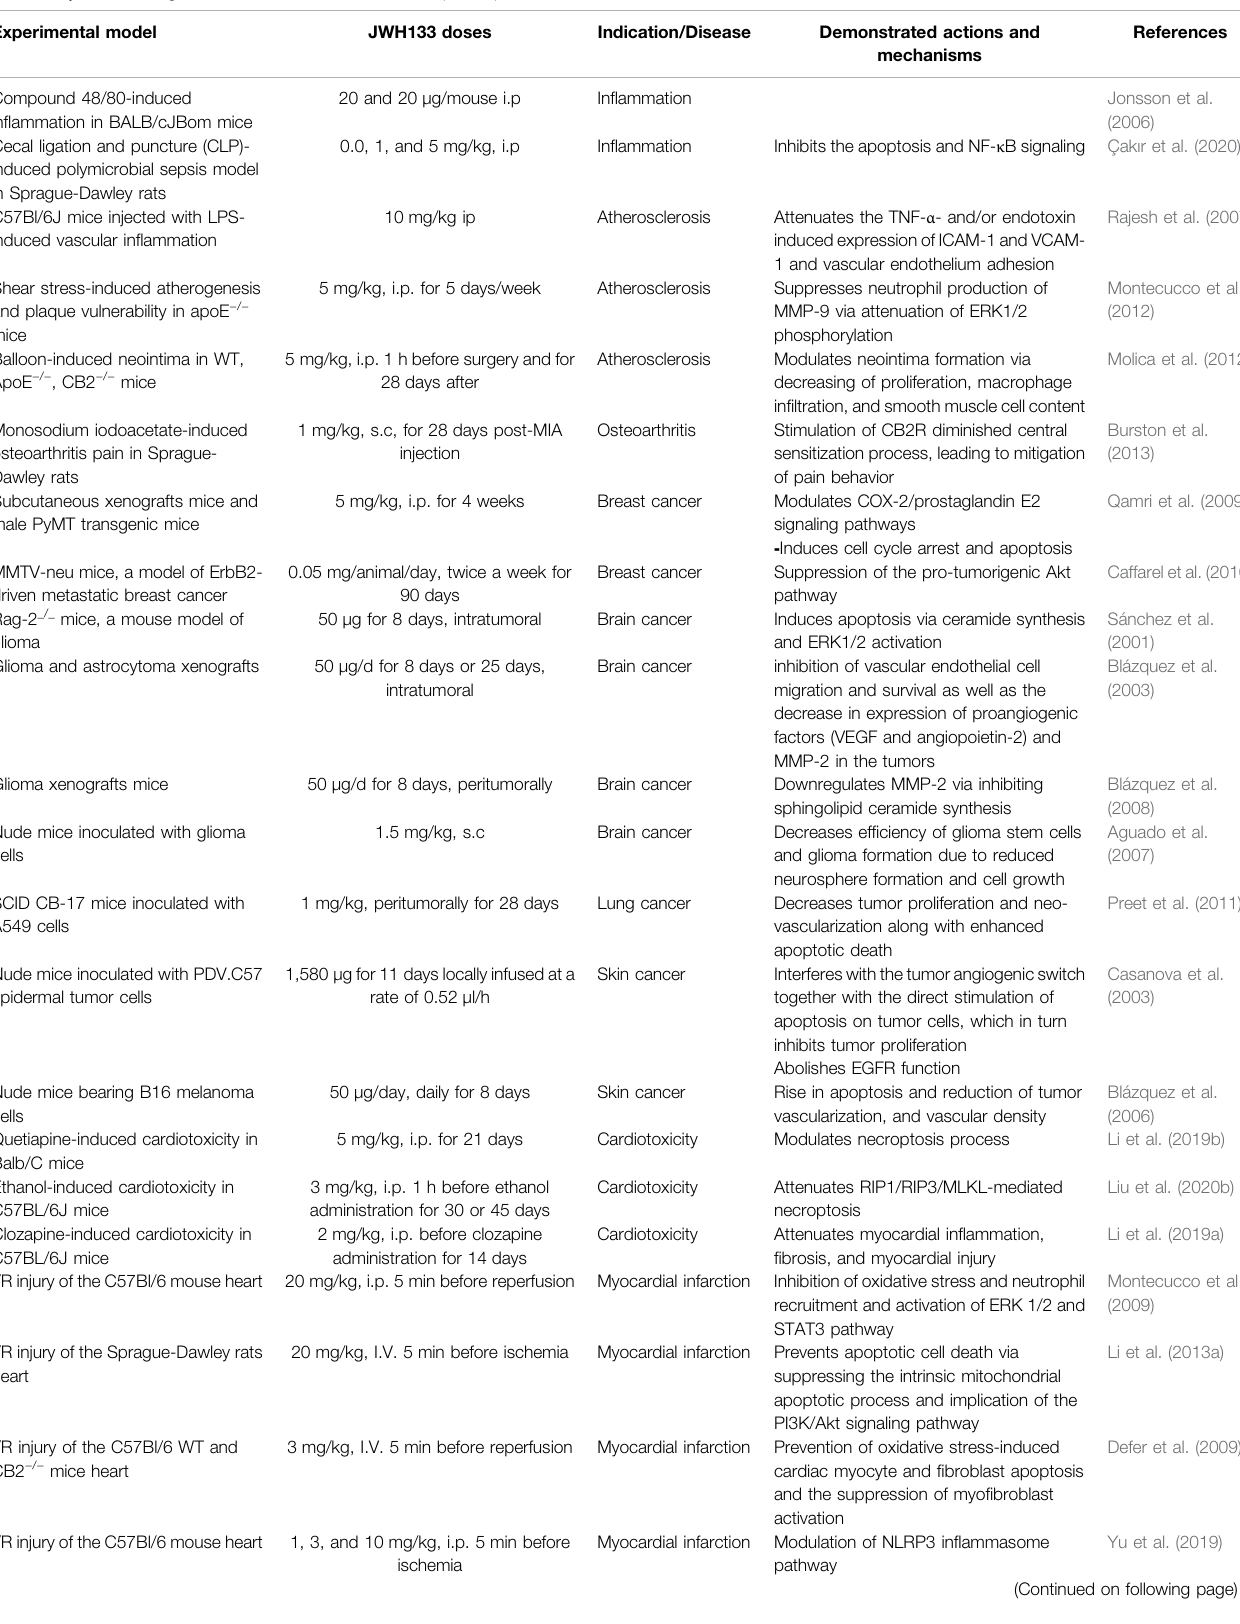
TABLE 2 | Pharmacological activities, mechanism and therapeutic potential of JWH133 in the in vivo studies. Experimental